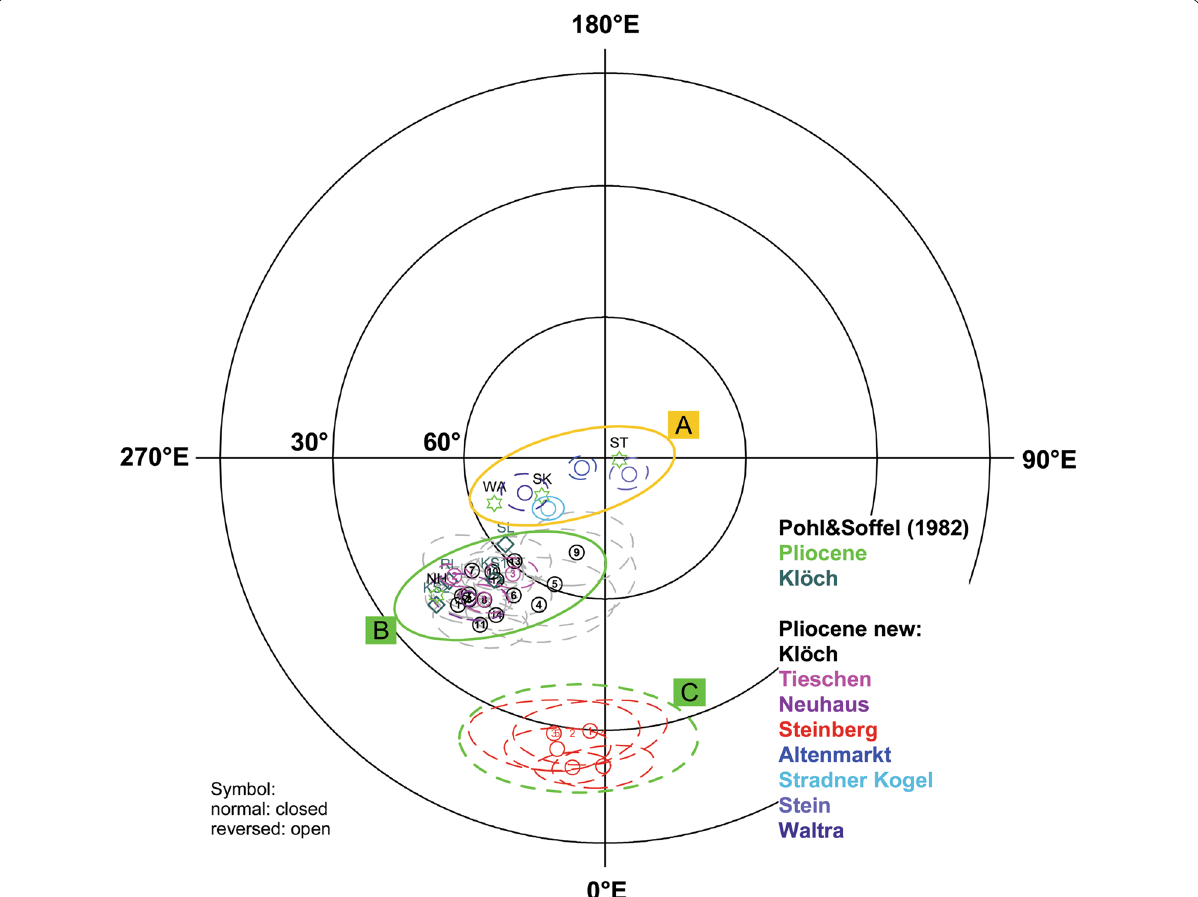
Fig. 10 Mean virtual geomagnetic pole (VGP) positions obtained in this study (circle, with error ellipses) in comparison with data of Pohl and Soffel (1982, green stars). Three clusters were identified (see text for